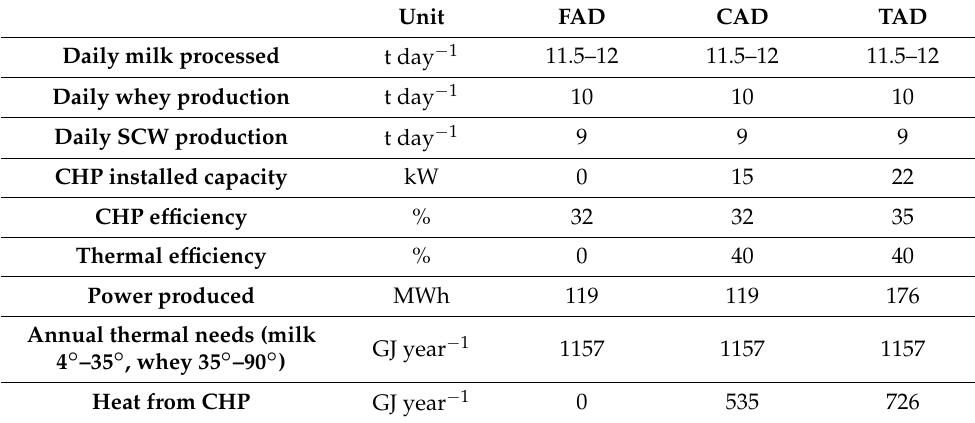
Table 2. Mass and energy flows related to the three systems. Unit FAD CAD TAD Daily milk processed t day −